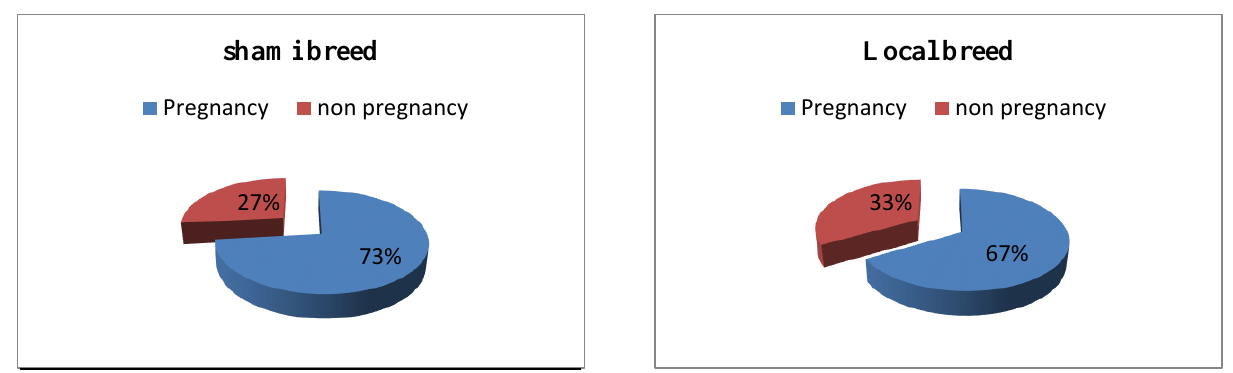
Figure, 1: the percentage of pregnant